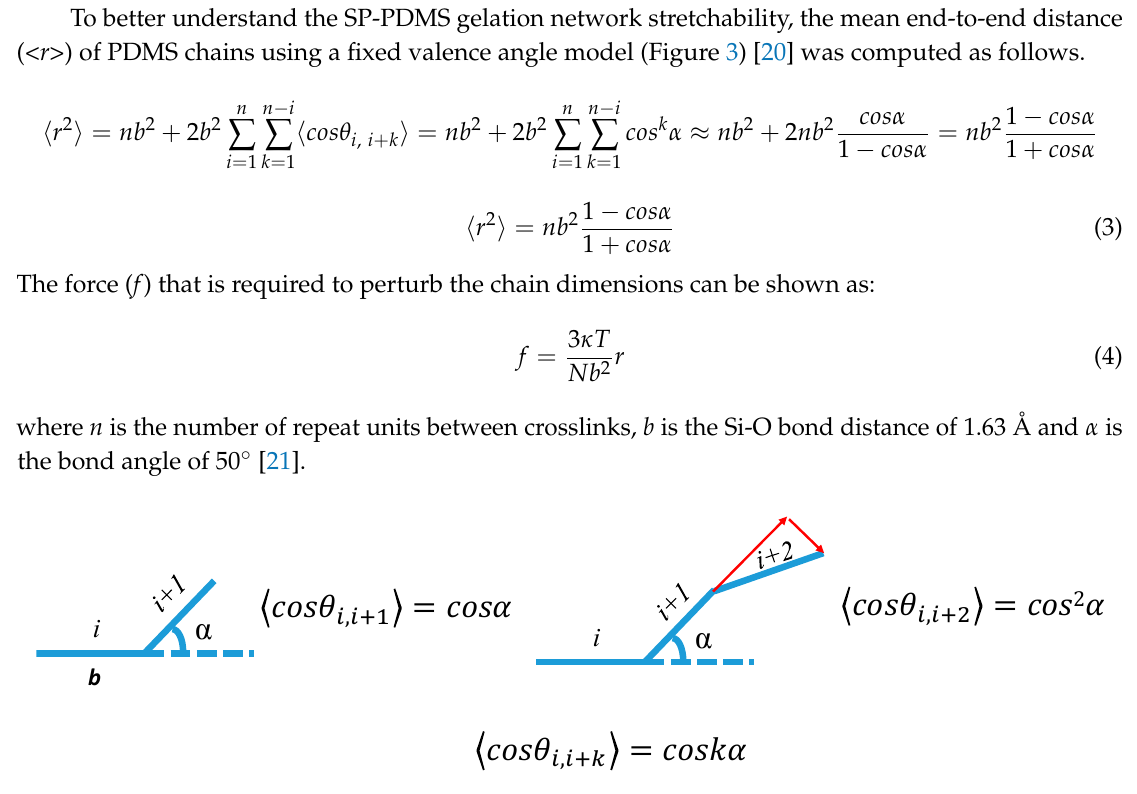
Figure 3. Schematic showing the calculation of end-to-end distance with fixed valence angles. The α is the bond angle and b is the bond length.